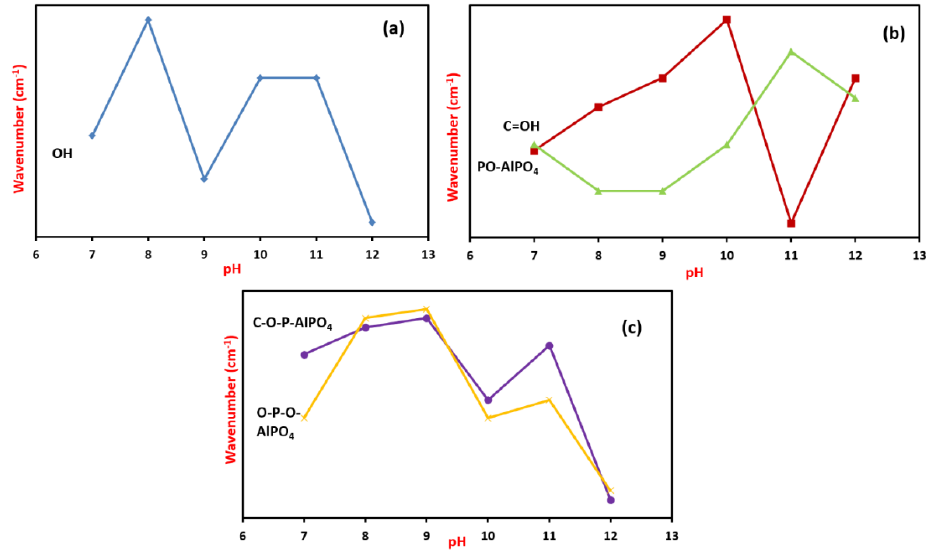
Figure 6. Selective FTIR bands of PPVA-AlPO 4 nanocomposite samples prepared at pH 7, 8, 9, 10, 11 and 12. ( a ) OH; ( b ) C=OH&PO−AlPO4; ( c ) C−O−P−AlPO4&